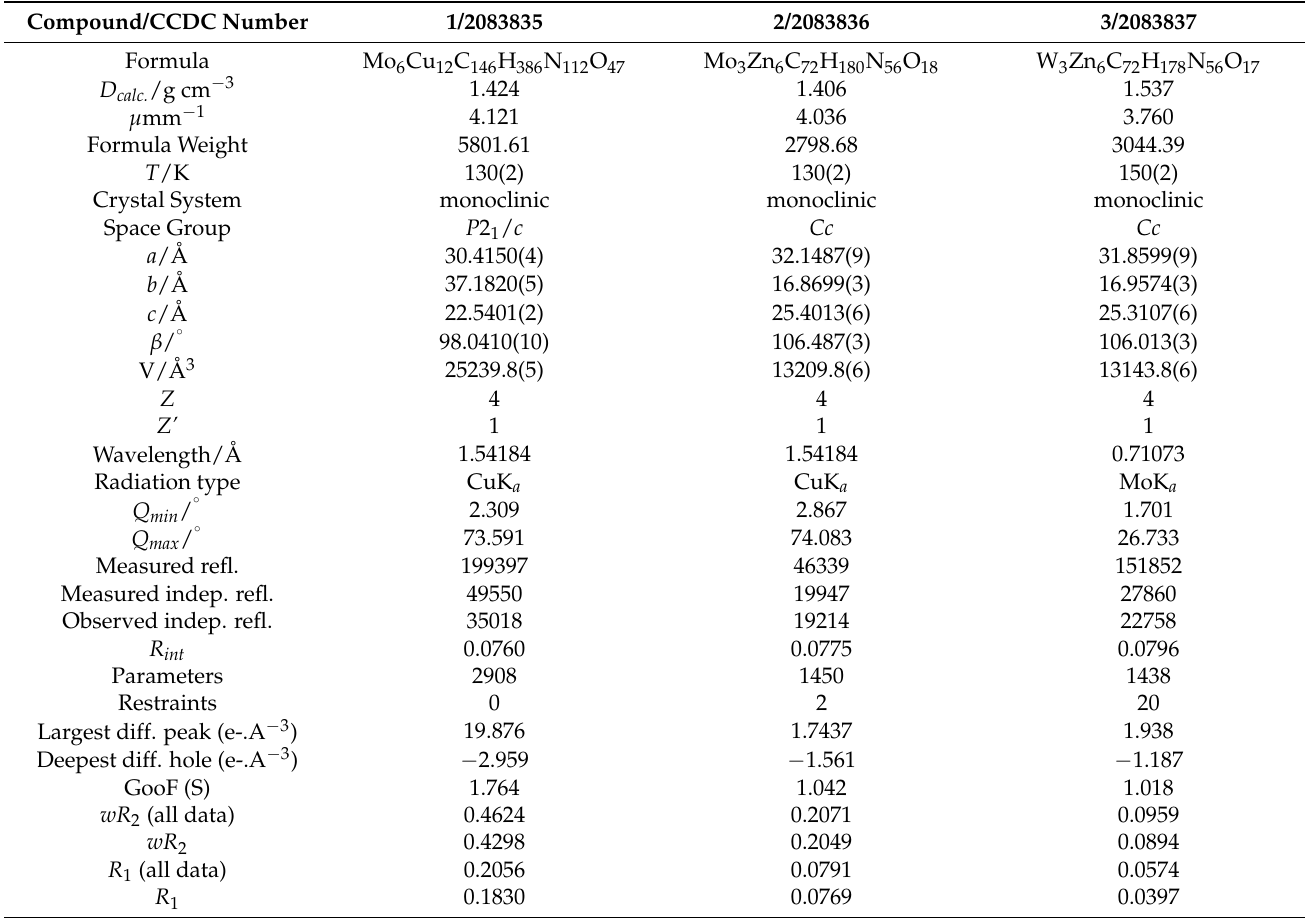
Table A1. Crystal and experimental data for 1 , 2 and 3 .